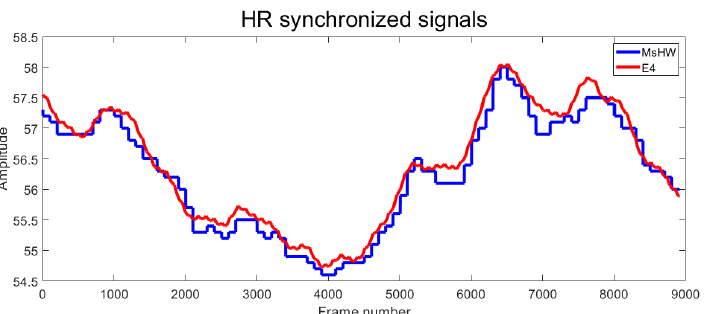
Figure 15. Representation of the raw data of the RH measurement. Horizontal axis: frame number. Vertical axis: Amplitude. Blue line: MsWH. Red line: Empatica E4 wristband.